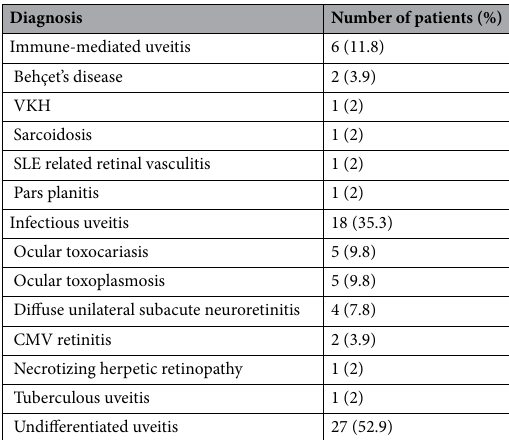
VA outcome. Figure 1 shows the mean VA of all 57 affected eyes as well as of eyes categorized into the non-infec- tious and infectious uveitis groups over the 5-year follow-up period, with the analyses performed using mixed- effects random intercept linear regression. Non-infectious uveitis eyes (mean logMAR VA = 1.81, [95% CI, 1.57– 2.06], Snellen equivalent = 20/1291) and infectious uveitis eyes (mean logMAR VA = 1.75, [95% CI, 1.39–2.11],